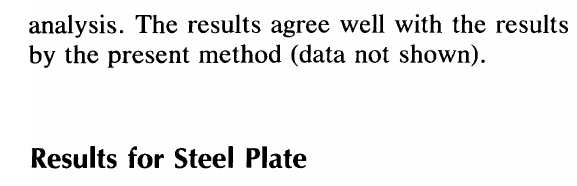
FIGURE 4 Stress distribution in the steel plate sUbjected to an underwater explosion: (-) wet plate, ( ... ) dry plate; TNT, 20 kg, D = 10